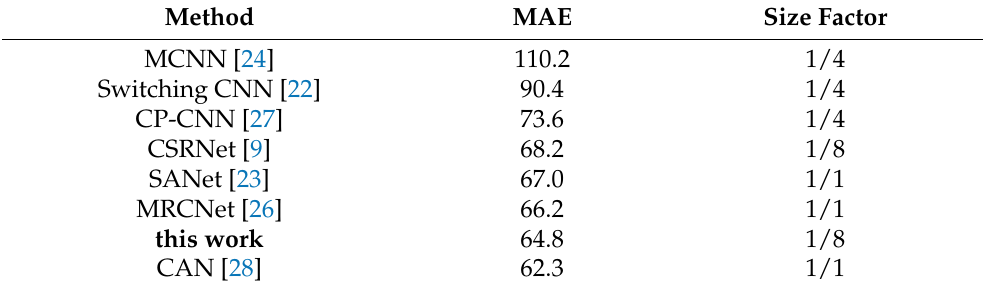
Table 3. Estimation errors on the ShanghaiTech Part A dataset sorted from largest to smallest MAE. We were able to boost the result of the baseline method [9] by 3.4 MAE without changing the network architecture. The spatial reduction size factor of the predicted density map is also given for each